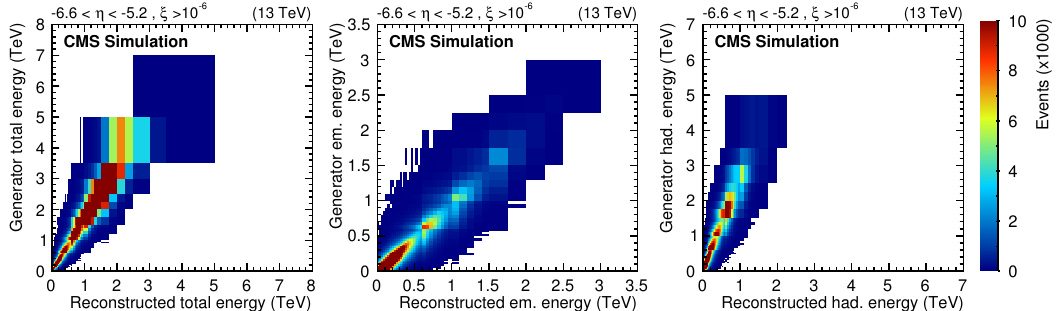
Figure 2 . Distributions of reconstructed energy as a function of the particle-level energy for pythia 8 CUETP8M1 for the total (left), electromagnetic (middle), and hadronic (right) energy in CASTOR. The color indicates the number of events. The selection (cid:24) > 10 (cid:0) 6 is explained in the